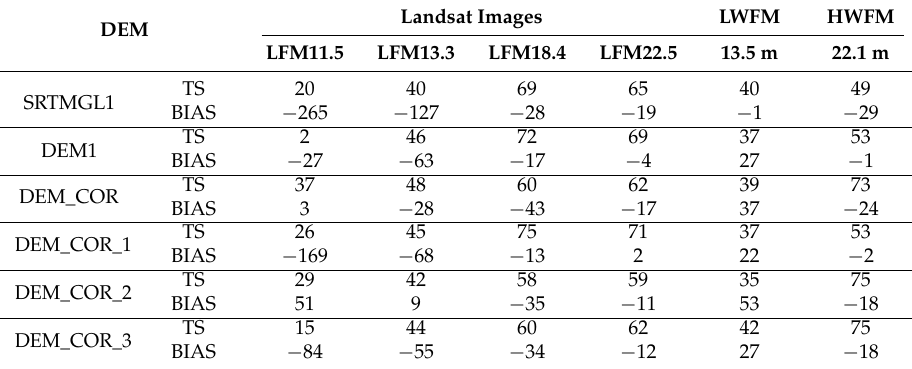
Table 4. Flooding extent: values of threat score (TS), bias index (BIAS) expressed in percent.